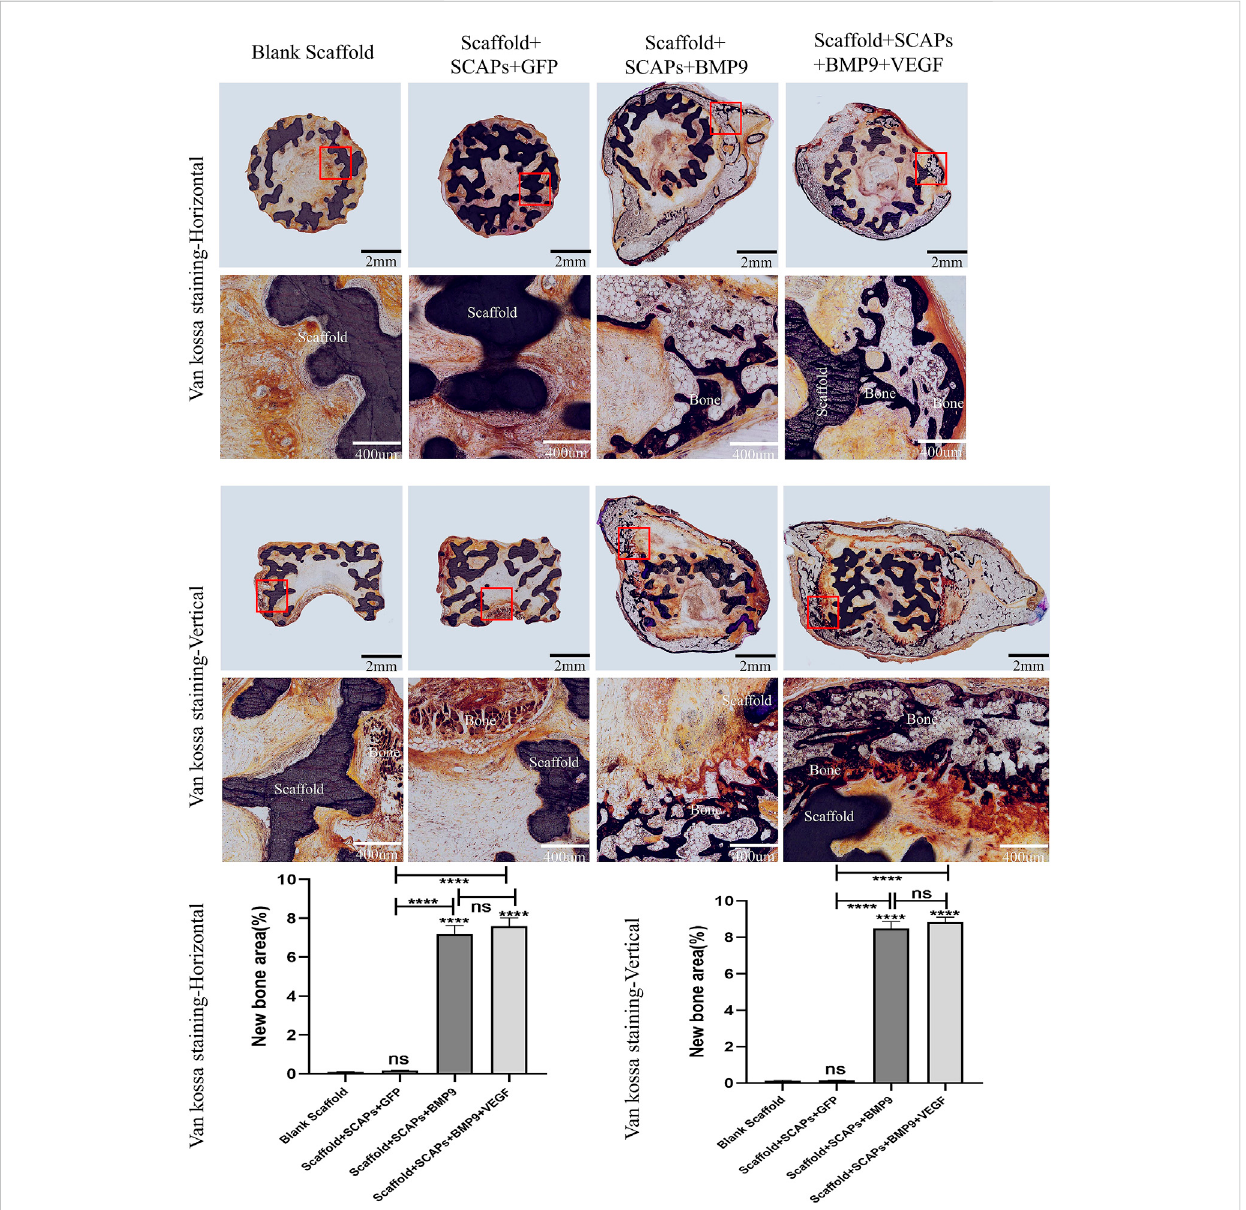
FIGURE 9 Histological analysis of bioceramic scaffolds implanted subcutaneously in nude mice after 2 months (Van Kossa staining).